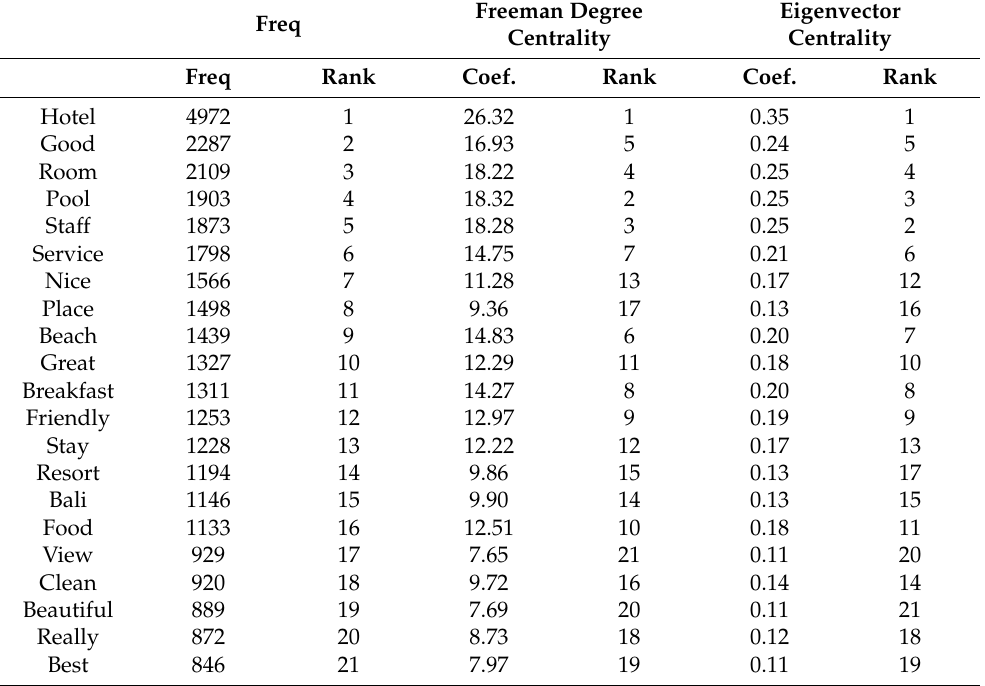
Table 4. Comparison of frequency and centrality of